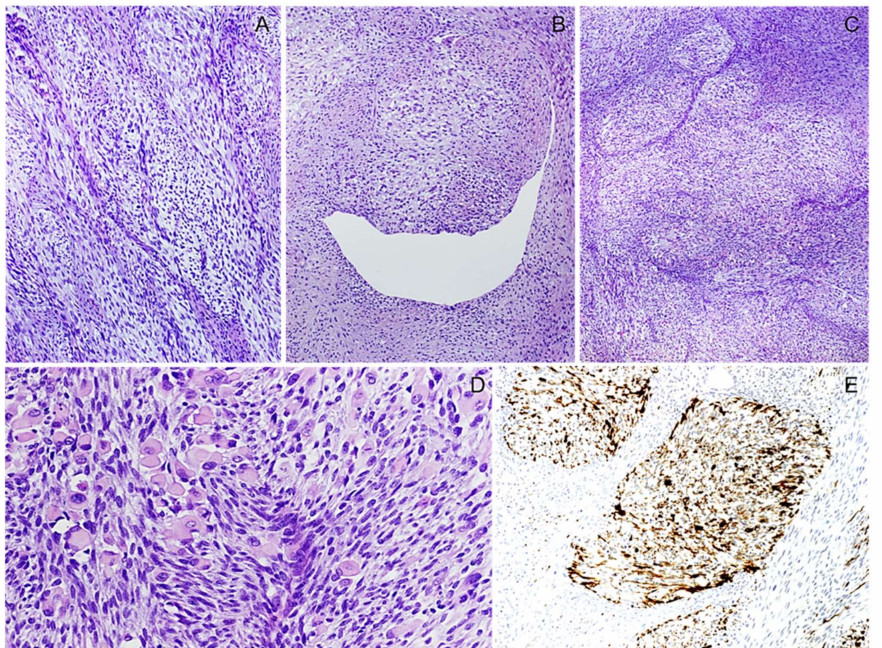
Figure 23. Triton Tumor. ( A ) Low-magnification image showing a spindle cell sarcoma with a fascicular growth pattern. ( B ) Perivascular condensation of neoplastic cells herniating into the vascular lumens is seen. ( C ) Notably, the tumor contains nodules that, at a higher magnification ( D ), are referred to as a heterologous mesenchymal component consisting of rhabdomyoblasts. ( E ) Rhabdomyoblasts are diffusely stained with